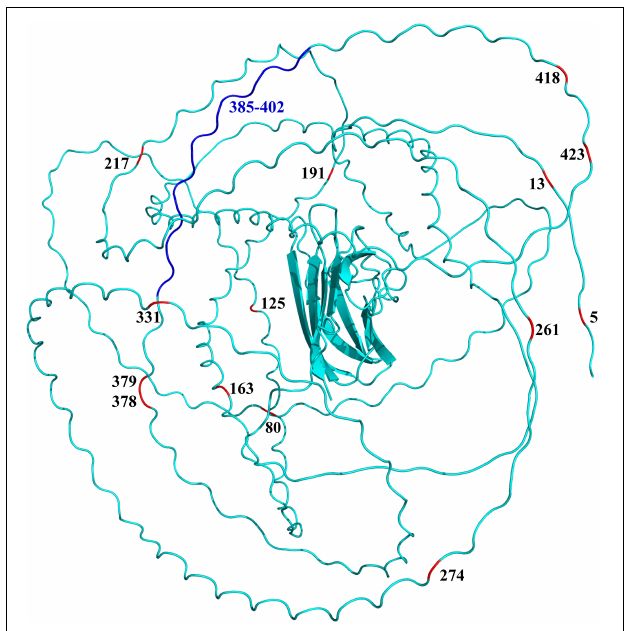
FIGURE 10 | Specific amino acid sites (red) and absent region (blue) mapped on the 3D structure of COL8A2 protein in mudskippers. The numbers represent the positions of these specific amino acid sites and